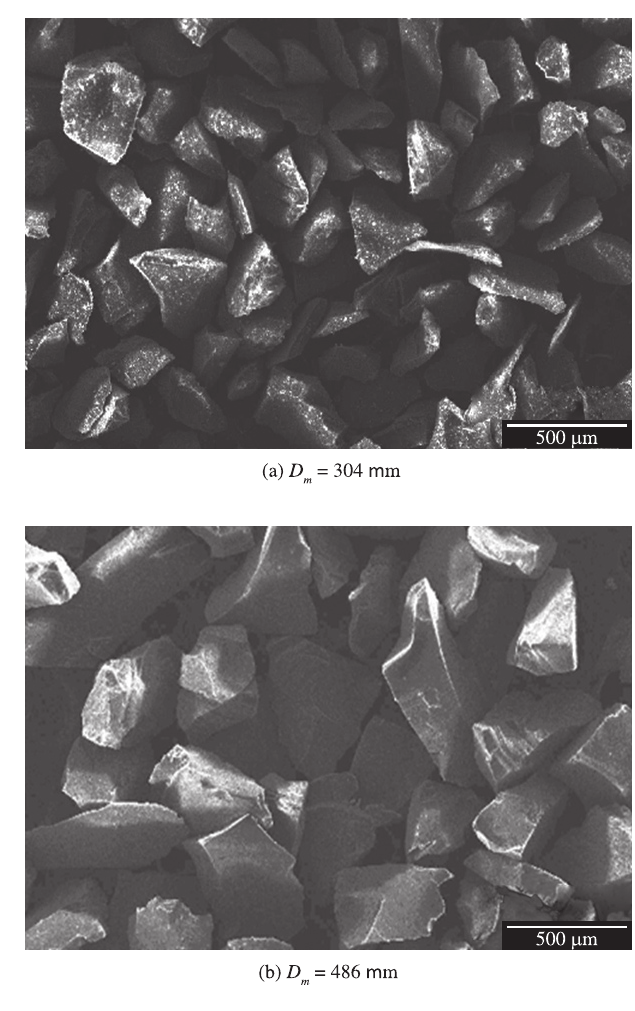
Figure 5. SEM micrographs of quartz particles with different mean grain